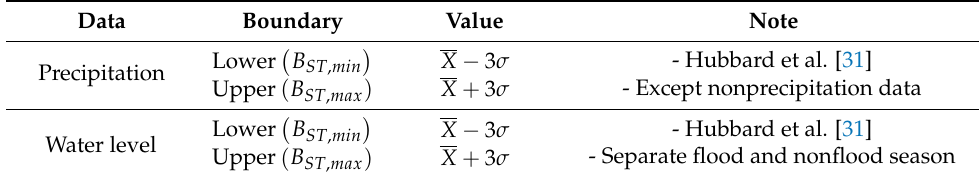
Table 4. Validation boundaries applied for statistical check